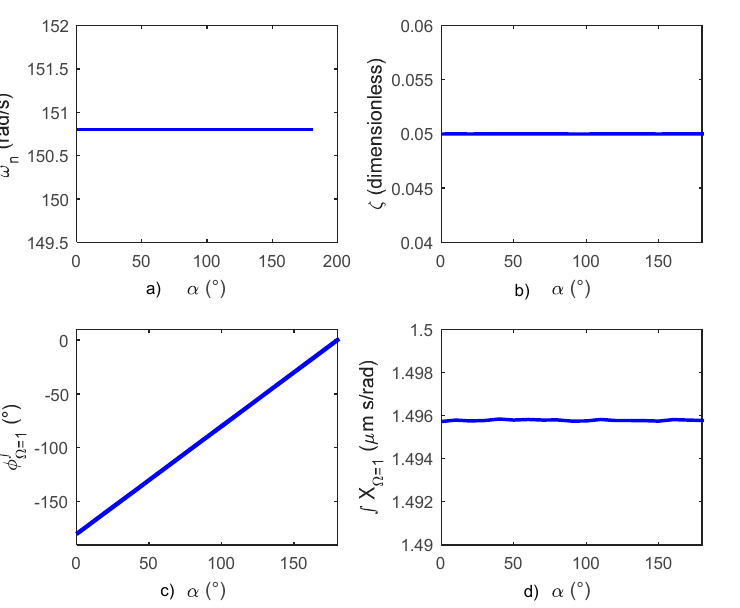
as shown in the Figure 7.